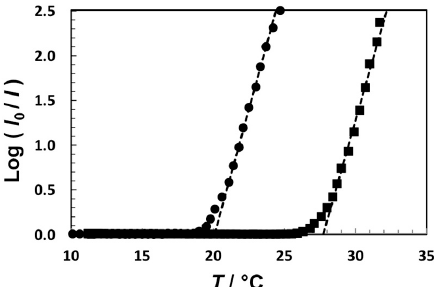
Figure 3. Temperature-turbidity profiles for aqueous solutions of 2 (squares) and 3 (circles). The dendrimer concentration is 4 mg/mL in both cases. The dashes lines, which are linear fits through the data with Log ( I 0 / I ) > 0.5, show the values of T ph = 20 °C ( 3 ) and T ph = 28 °C ( 2 ) extrapolated at Log ( I 0 / I ) = 0.